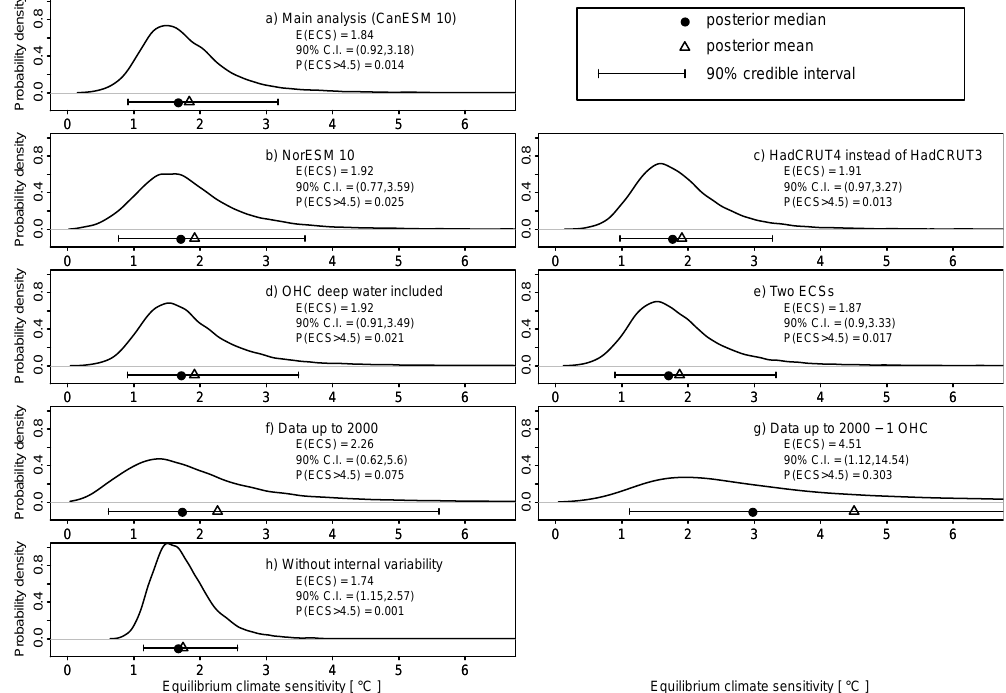
Fig. 2. Posterior distributions for the ECS for different analyses. In (a) the main analysis, (b) with NorESM data to estimate n liv t , (c) sensitivity test using HadCRUT4 instead of HadCRUT3 data, (d) sensitivity test using data for OHC change below 700m, (e) sensitivity test allowing different ECSs in each hemisphere, (f) updating the model with data only up to 2000, (g) updating the model with data only up to 2000 and using only one OHC data series and (h) sensitivity test without the long-term internal variability (without the n liv t term). The estimated mean of ECS, the 90%C.I. and the probability of ECS being larger than 4.5 ◦ C are given in the text box of each panel. The 90%C.I. (the error bar) and estimated posterior mean (triangle) and median (black dot) are also indicated in each panel.